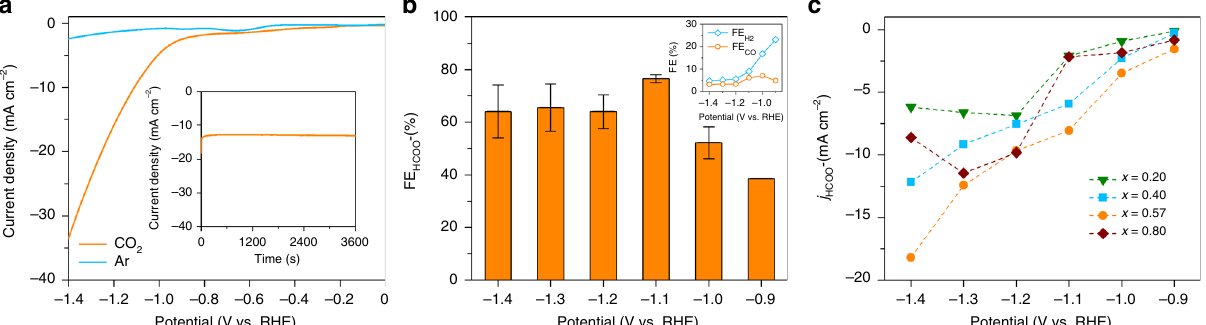
Fig. 6 CO 2 RR activity of the Bi x Sn 1 − x nano-alloy catalysts. a Linear sweep voltammetry (scan rate: 5 mV s − 1 ) of the eutectic sample in CO 2 and Ar saturated 0.1 M KHCO 3 . The inset shows a chronoamperometric j – t curve at an applied potential of − 1.2 V vs. RHE. b Dependence of FE potential for the eutectic sample in CO 2 saturated 0.1 M KHCO 3 . The inset shows the dependence of FE H2 and FE CO of the eutectic nano-alloy over the same potential range. c Comparison of j of different Bi – Sn nano-alloy samples as a function of the applied potential in CO 2 saturated 0.1 M KHCO 3 HCOO (cid:2) NATURE COMMUNICATIONS| (2019) 10:4645